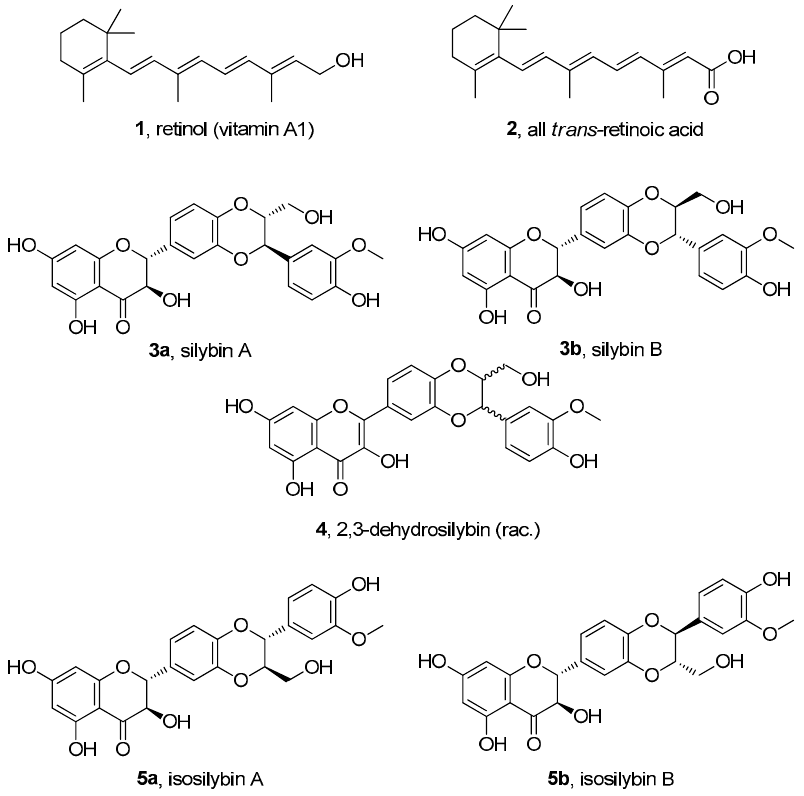
Figure 1. Structures of retinol, retinoic acid and selected flavonolignans from Silybum marianum (L.) Gaertn. (Asteraceae). Note to the numbering: Natural silybin is extracted and often used as an approximately equimolar diastereomeric mixture of silybin A ( 3a ) and silybin B ( 3b ). Diastereomeric mixtures of silybin and its derivatives will be denoted with the respective number and letters ab (for example natural mixture of 3a and 3b will be denoted 3ab ).